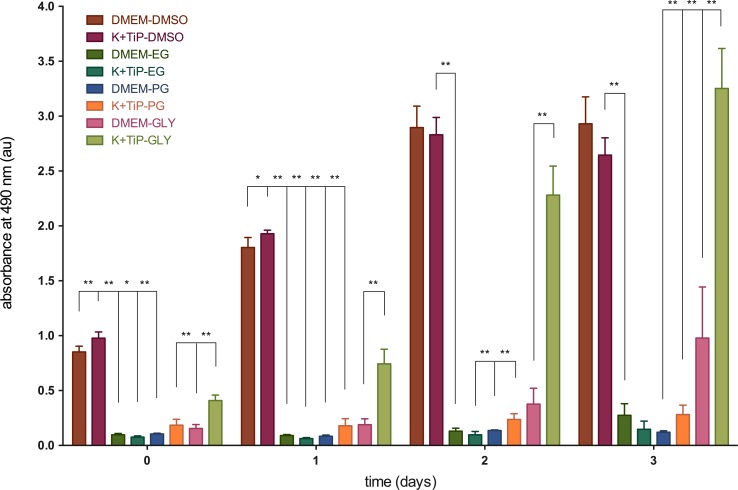
Viable cells in proliferation after vitrification.The CellTiter 96® AQueous One Solution Cell Proliferation Assay (COS, Promega Corporation, Mannheim, Germany) was used to determine viable cells in proliferation at one hour after thawing and at day one, two, and three. Figure 5 illustrates the absorption of viable cells in proliferation after vitrification. DMEM = DMEM Ham’s F-12 Gln+, 20% FBS, and 3M of one of the CPAs; K+TiP = K+TiP. 0.5M sucrose, 20% FBS, and 3M of one of the CPAs; DMSO = dimethyl sulfoxide; EG = ethylene glycol; PG = propylene glycol; GLY = glycerin; * = significant (p < 0.05); ** = medium significant (p < 0.01); au = absorbance units.